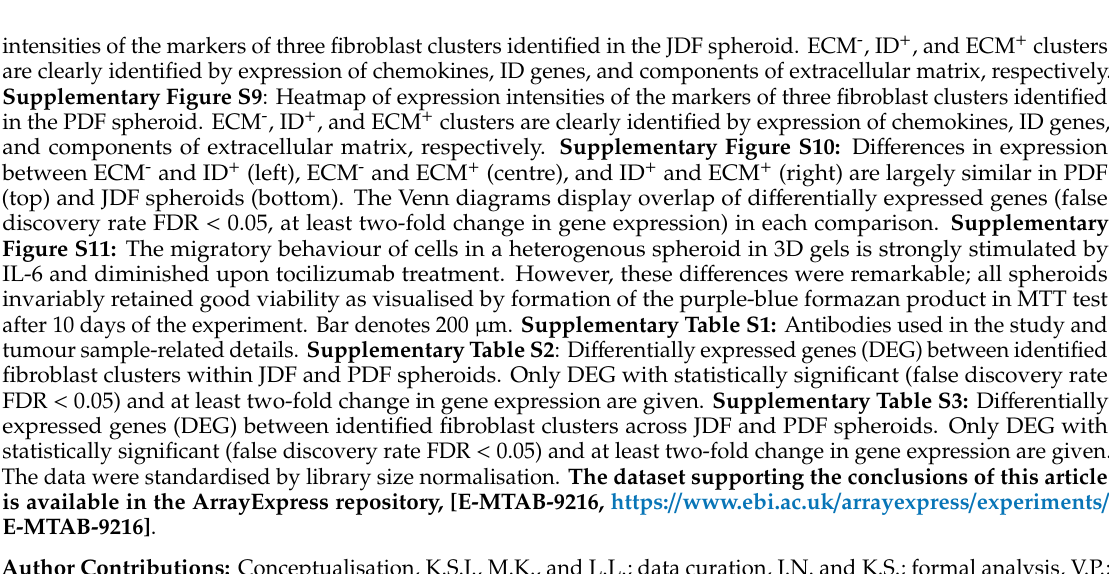
intensities of the markers of three fibroblast clusters identified in the JDF spheroid. ECM - , ID + , and ECM + clusters are clearly identified by expression of chemokines, ID genes, and components of extracellular matrix, respectively. Supplementary Figure S9 : Heatmap of expression intensities of the markers of three fibroblast clusters identified in the PDF spheroid. ECM - , ID + , and ECM + clusters are clearly identified by expression of chemokines, ID genes, and components of extracellular matrix, respectively. Supplementary Figure S10: Di ff erences in expression between ECM - and ID + (left), ECM - and ECM + (centre), and ID + and ECM + (right) are largely similar in PDF (top) and JDF spheroids (bottom). The Venn diagrams display overlap of di ff erentially expressed genes (false discovery rate FDR < 0.05, at least two-fold change in gene expression) in each comparison. Supplementary Figure S11: The migratory behaviour of cells in a heterogenous spheroid in 3D gels is strongly stimulated by IL-6 and diminished upon tocilizumab treatment. However, these di ff erences were remarkable; all spheroids invariably retained good viability as visualised by formation of the purple-blue formazan product in MTT test after 10 days of the experiment. Bar denotes 200 µ m. Supplementary Table S1: Antibodies used in the study and tumour sample-related details. Supplementary Table S2 : Di ff erentially expressed genes (DEG) between identified fibroblast clusters within JDF and PDF spheroids. Only DEG with statistically significant (false discovery rate FDR < 0.05) and at least two-fold change in gene expression are given. Supplementary Table S3: Di ff erentially expressed genes (DEG) between identified fibroblast clusters across JDF and PDF spheroids. Only DEG with statistically significant (false discovery rate FDR < 0.05) and at least two-fold change in gene expression are given. The data were standardised by library size normalisation. The dataset supporting the conclusions of this article is available in the ArrayExpress repository, [E-MTAB-9216, https: // www.ebi.ac.uk / arrayexpress / experiments / E-MTAB-9216]